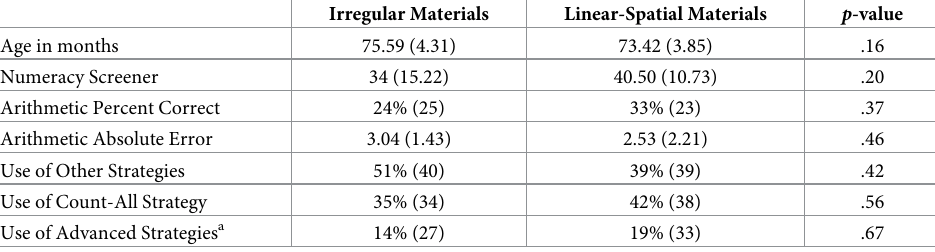
Table 1. Pretest mean scores for children in the irregular and linear-spatial conditions. Standard deviations are presented in parentheses. P-values were calculated from independent sample t-tests comparing children between the two training